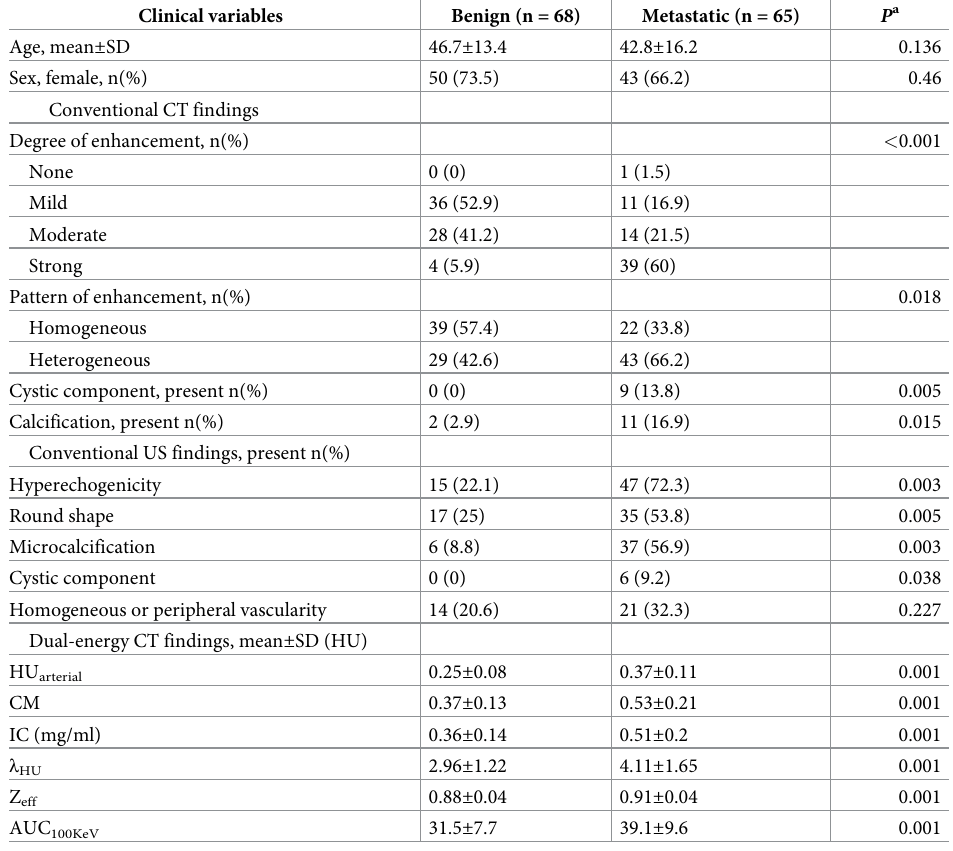
Table 2. Comparison of conventional and dual-energy CT findings of benign and metastatic lymph nodes.